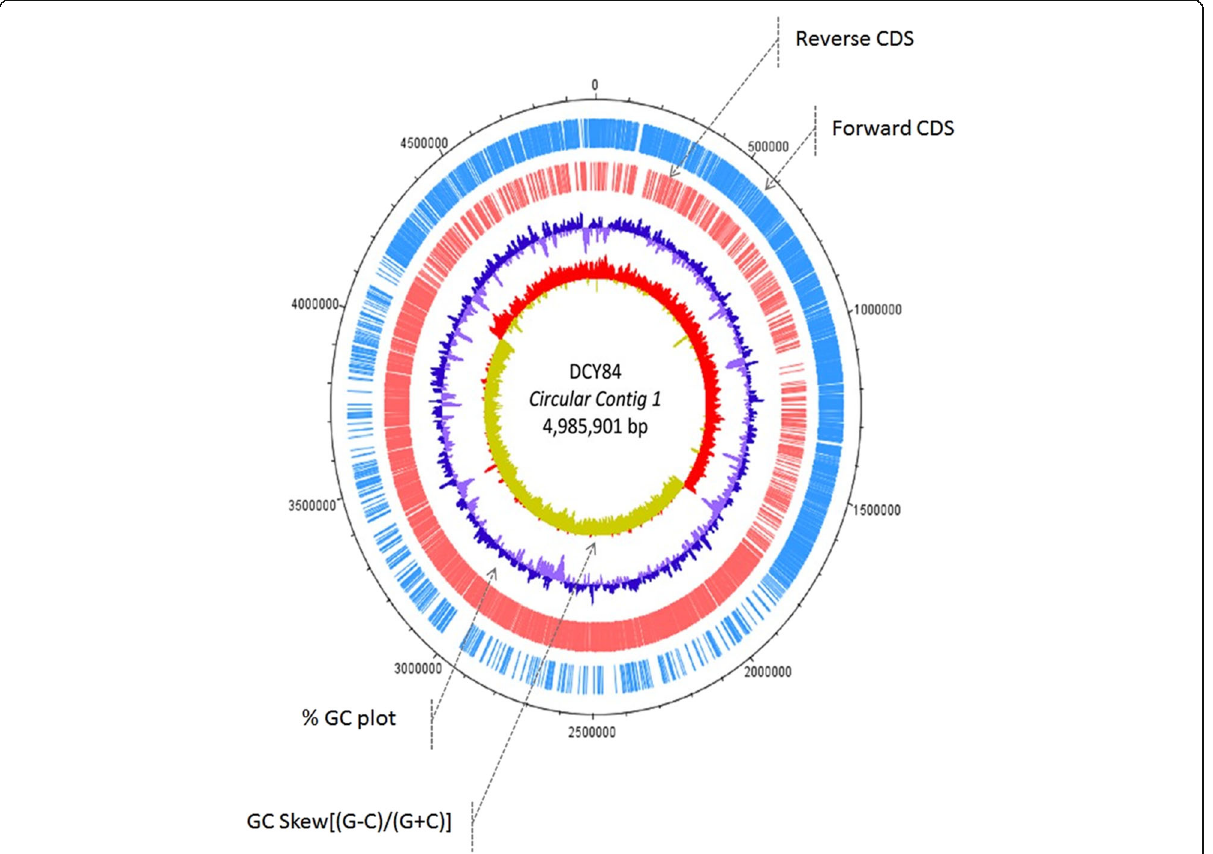
Fig. 4 Graphical circular map of the chromosome. From the outside to the center, genes on the forward strand are colored by COG categories (only genes assigned to COG), genes on the reverse strand are colored by COG categories (only genes assigned to COG), RNA genes (tRNAs green, rRNAs red), G + C content, and GC skew. Purple and olive colors indicate negative and positive values,